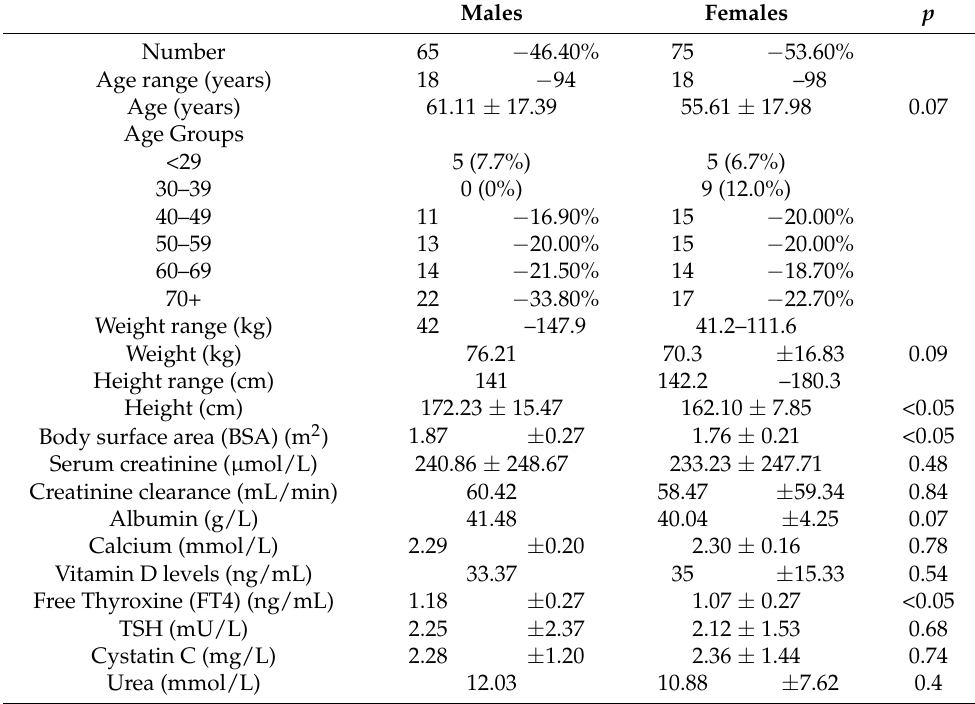
Table 1. Demographic and biochemical characteristics of the study